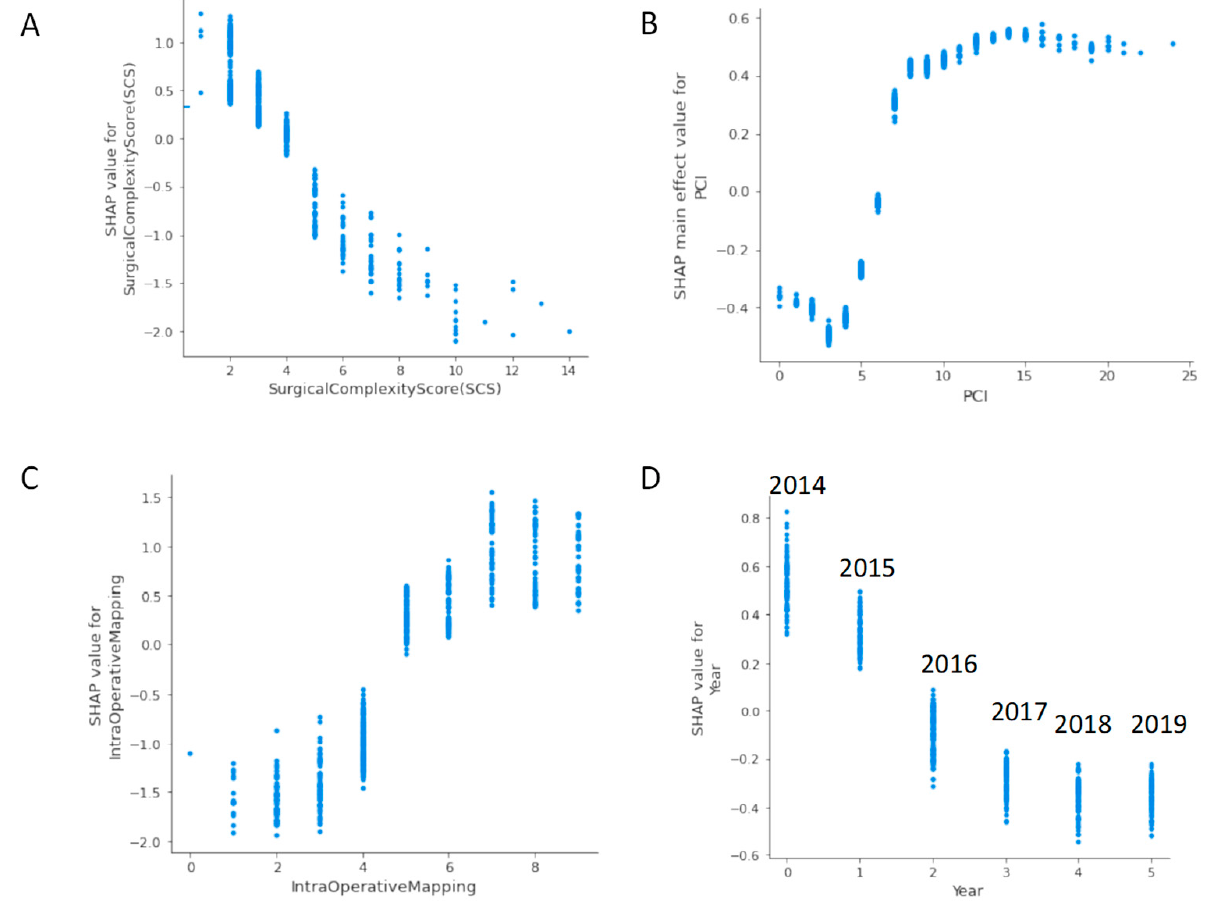
Figure 3. SHAP dependence plots of the top-six global explainability features versus their SHAP value for R0 resection prediction: ( A ) IMO score, ( B ) PCI, ( C ) SCS, and ( D ) year of surgery.